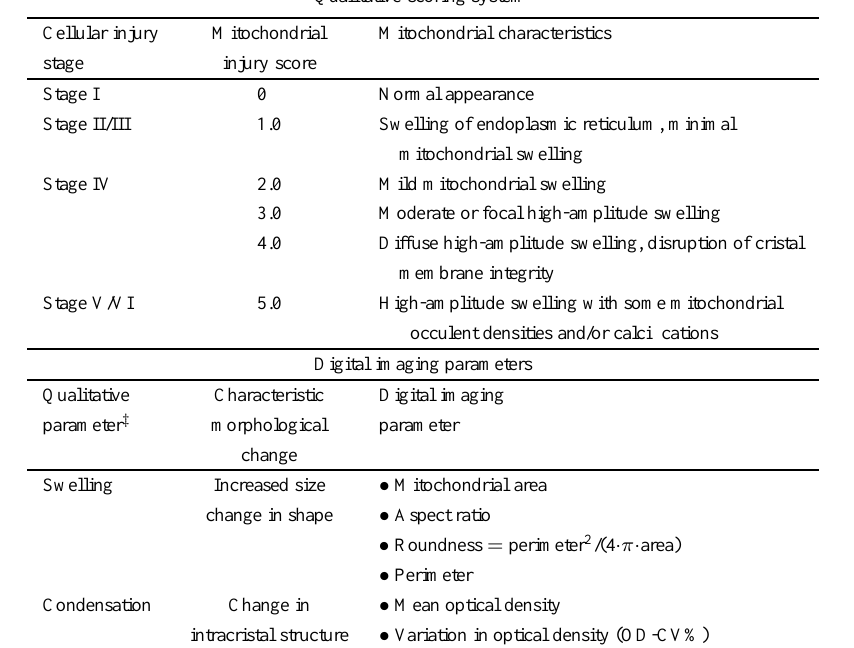
Qualitative scoring system